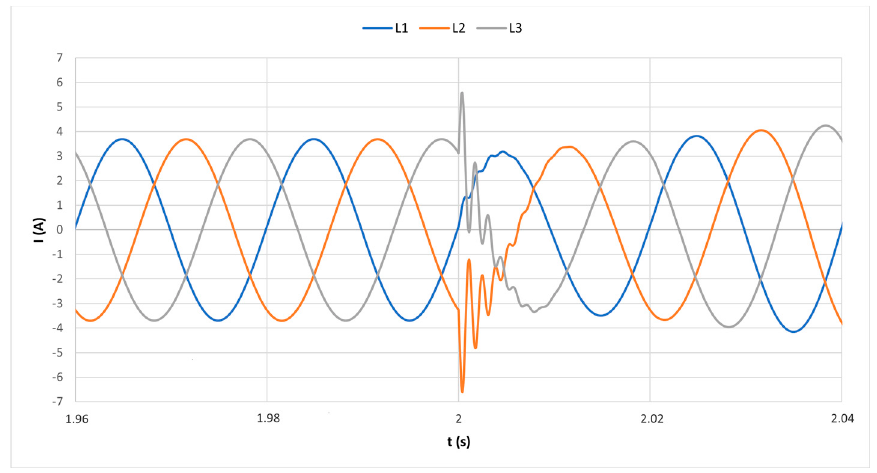
Figure 20. Simulated values of battery energy storage system model currents during a 3-Ph ground fault condition at the source.